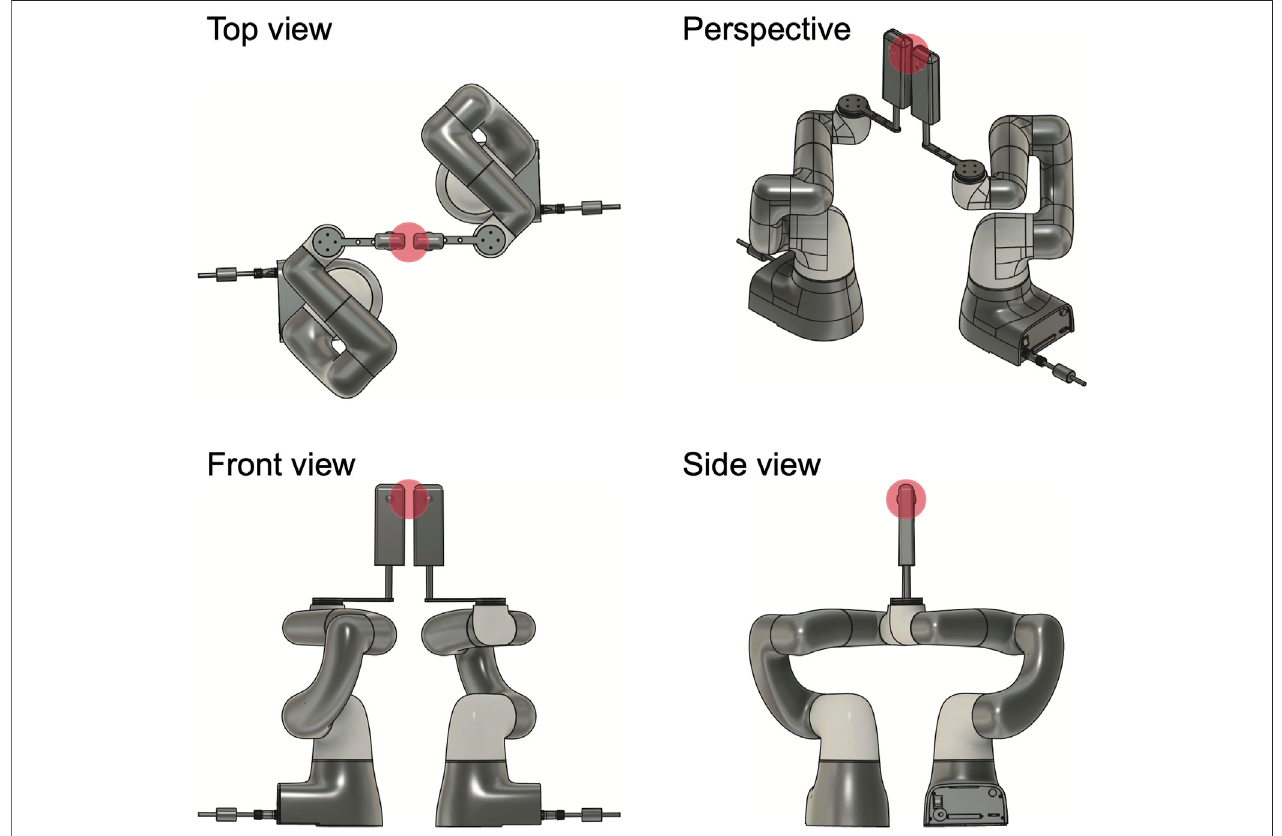
FIGURE 2 | Multiview plan of TeleParallax. The red sphere indicates the area of lens